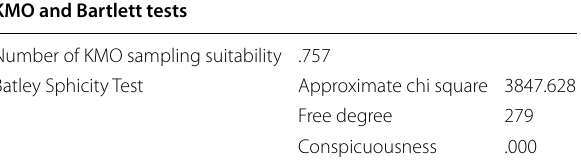
Table 5 Questionnaire validity test form KMO and Bartlett tests Number of KMO sampling suitability .757